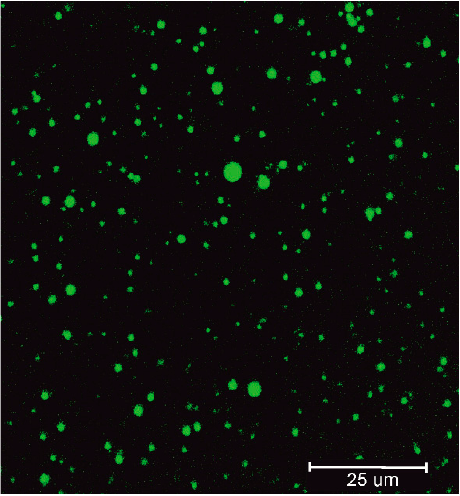
Figure 1. Representative picture of fluorescently labeled emulsion droplets dispersed in water (t = 0 min).